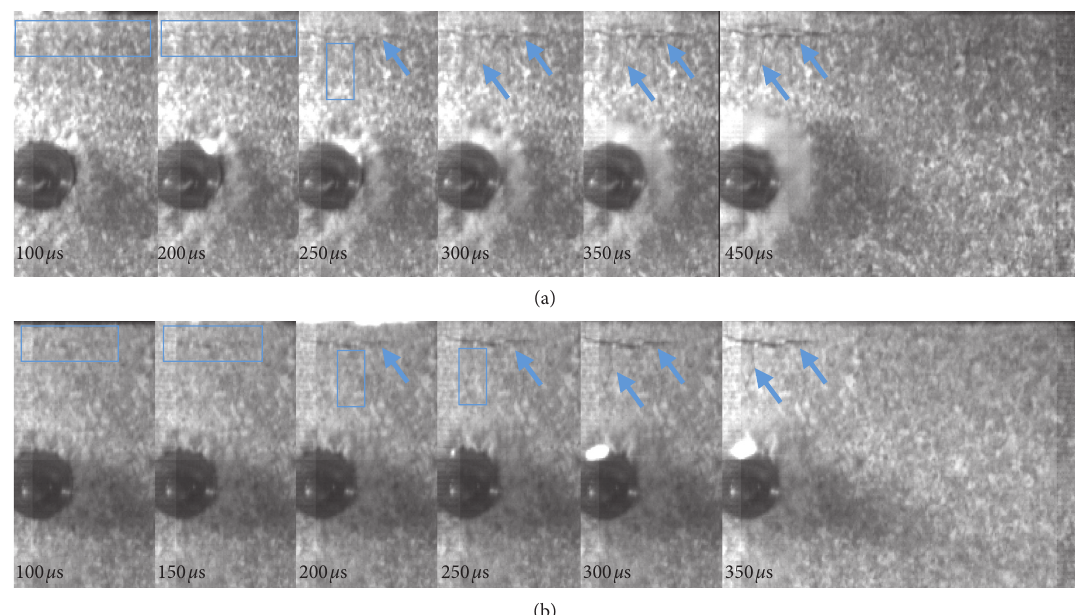
Figure 3: Images of the evolution of visible cracks. (a) Test 2 and (b) test